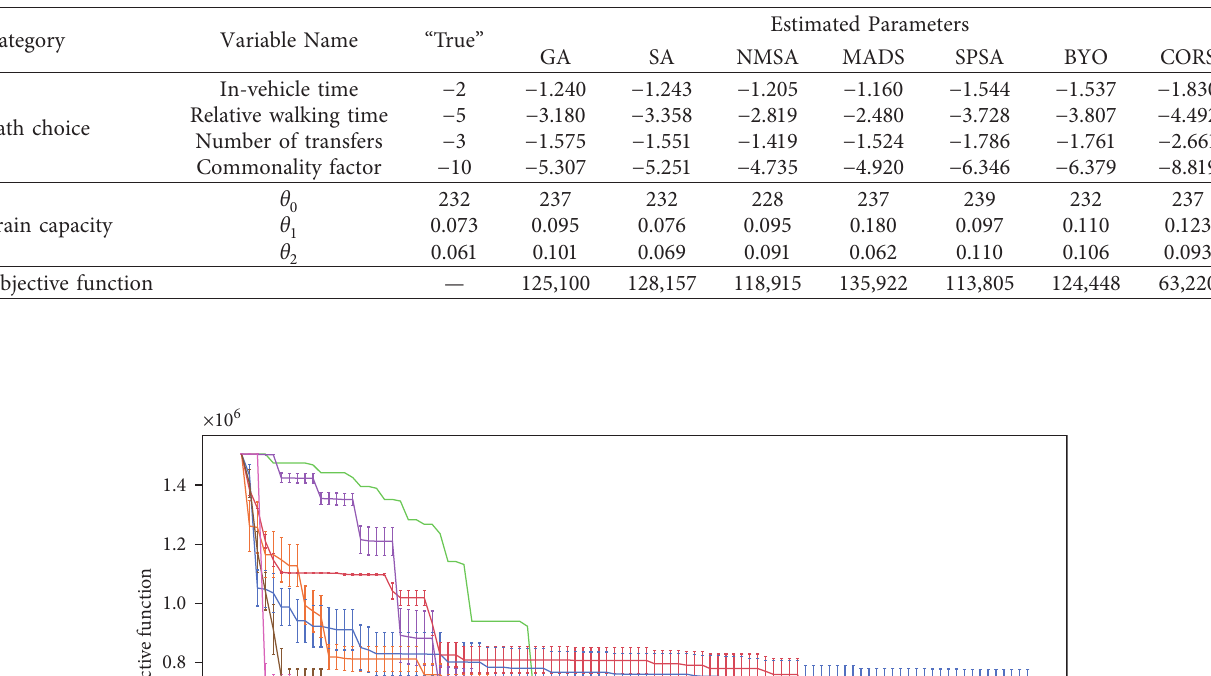
Table 6: Estimation results of the deterministic path choice